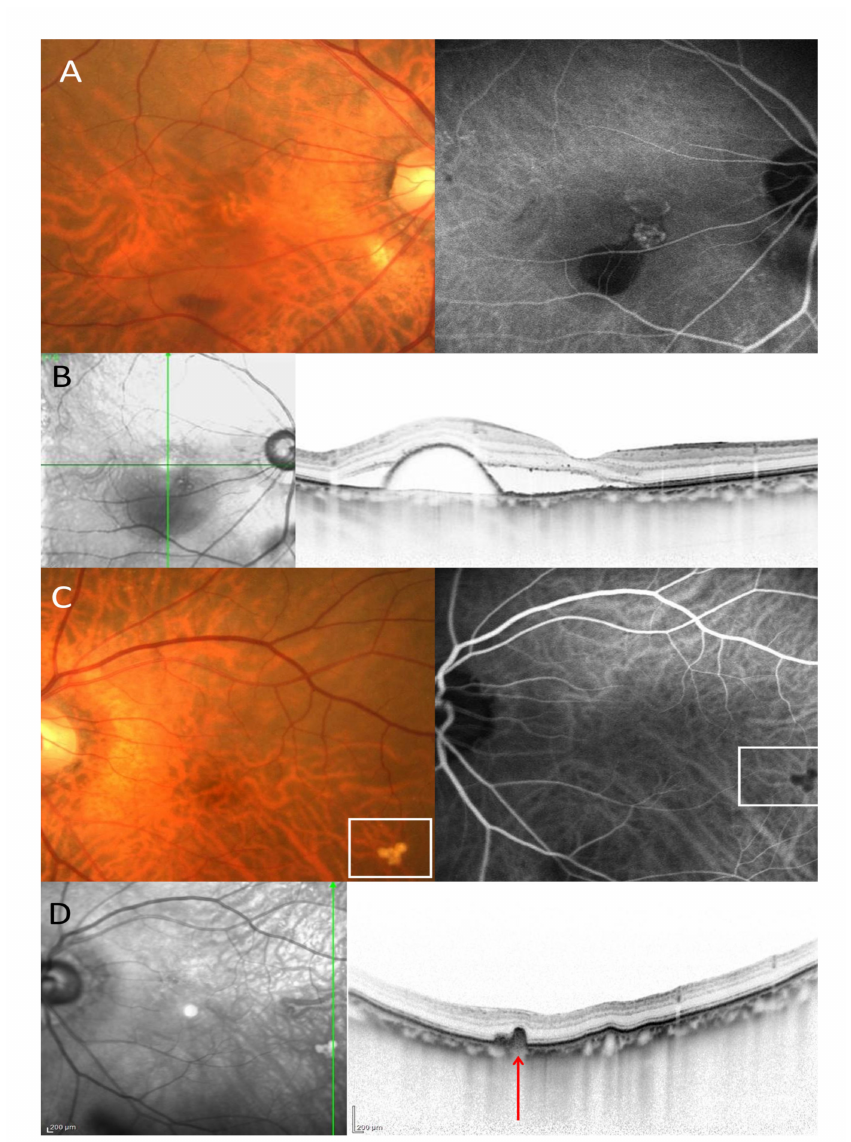
Figure 1. An eighty-year-old male patients with polypoidal choroidal vasculopathy. ( A ). Color fundus photography showed hemorrhagic pigment epithelial detachment in the right eye. On the indocyanine green angiography (ICGA), polypoidal lesion and branching vascular network was seen in the right eye. ( B ). A vertical OCT scan through the fovea showed subretinal fluid and pigment epithelial detachment. ( C ). Color fundus photography showed soft drusen surrounded by a white square in the left eye. On the ICGA, the soft drusen exhibited hypofluorescent in the left eye. ( D ). A vertical OCT scan through the soft drusen showed retinal pigment epithelial bump (red